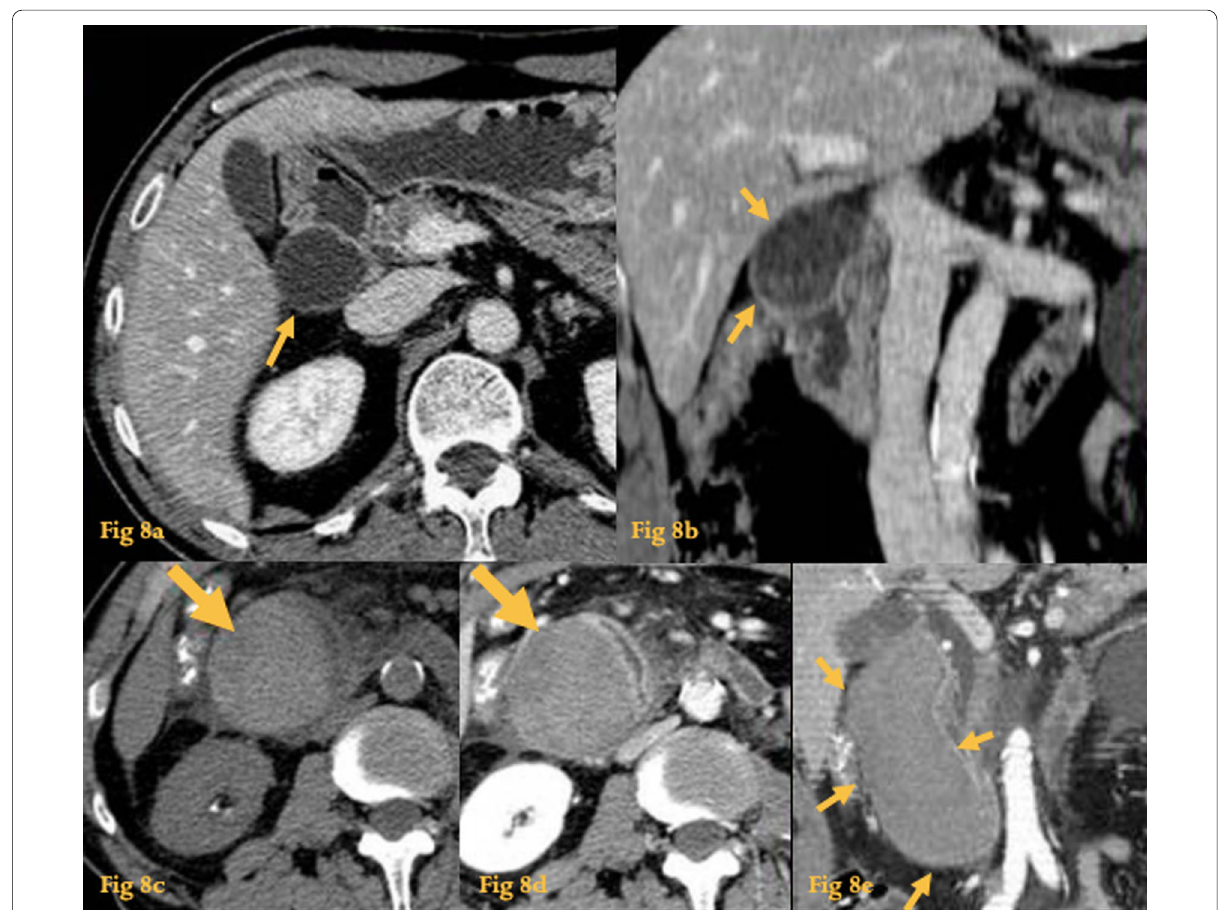
Fig. 8 Duplication cyst. Abdominal CT ( a , b ) fortuitus finding of a peri‑duodenal cystic lesion (arrows), with mural enhancement, which caused extrinsic compression on the descending duodenum. Abdominal CT of the same patient some months after ( c – e ), when he started complaining of abdominal pain, shows increasement in size and spontaneously hyperdense content on unenhanced images (arrow on c ). Histopathological study of the resected specimen revealed a duodenal duplication cyst complicated with